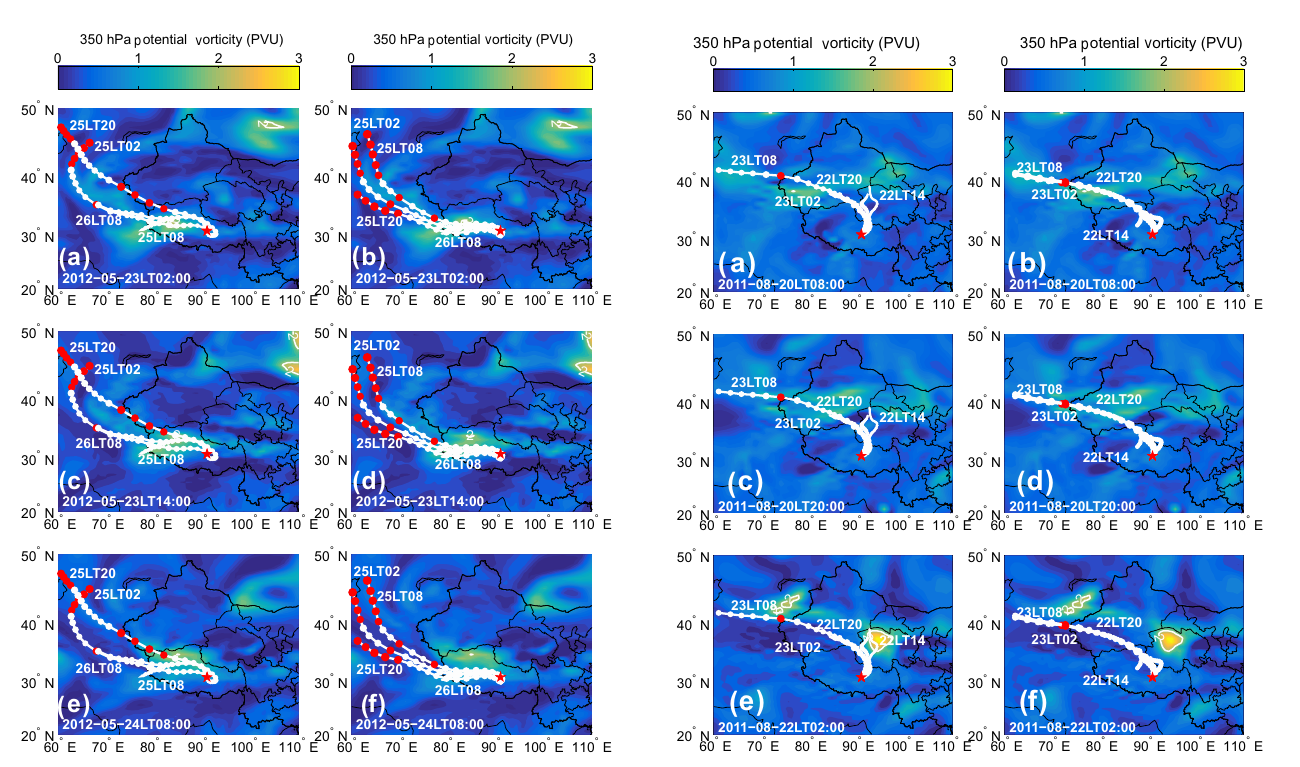
Figure 9. The 350hPa potential vorticity fields at three time-points during 23–24 May 2012 and back trajectories of air masses arriving at 500m (a, c, e) and 1500m (b, d, f) above the ground of NMC (red star) during 25–26 May 2012.